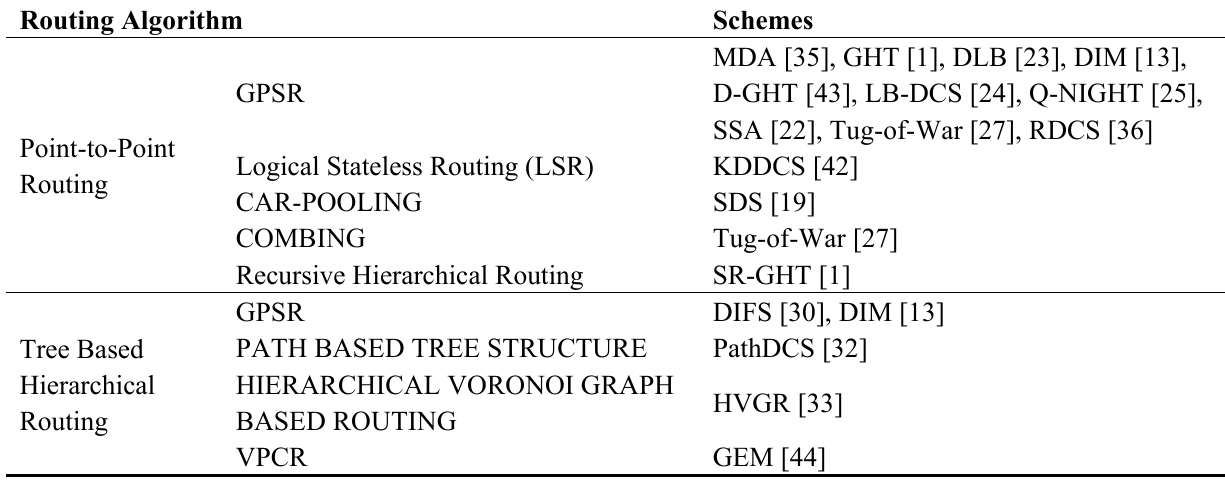
Table 5. Summary of DCS Schemes Based on Routing Algorithm.